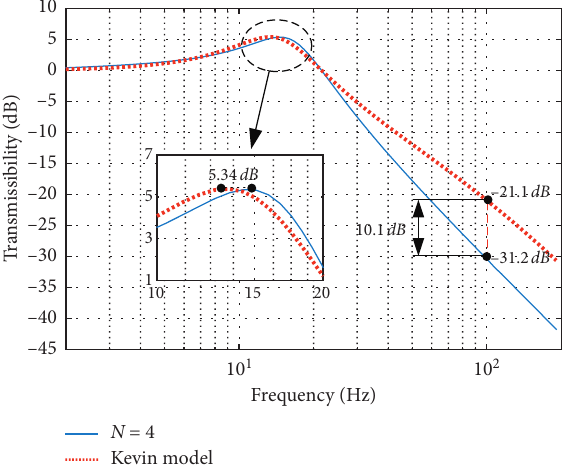
Figure 7: Comparison of the acceleration transmissibility of the relaxation-type damper for N � 4 and a Kevin model.